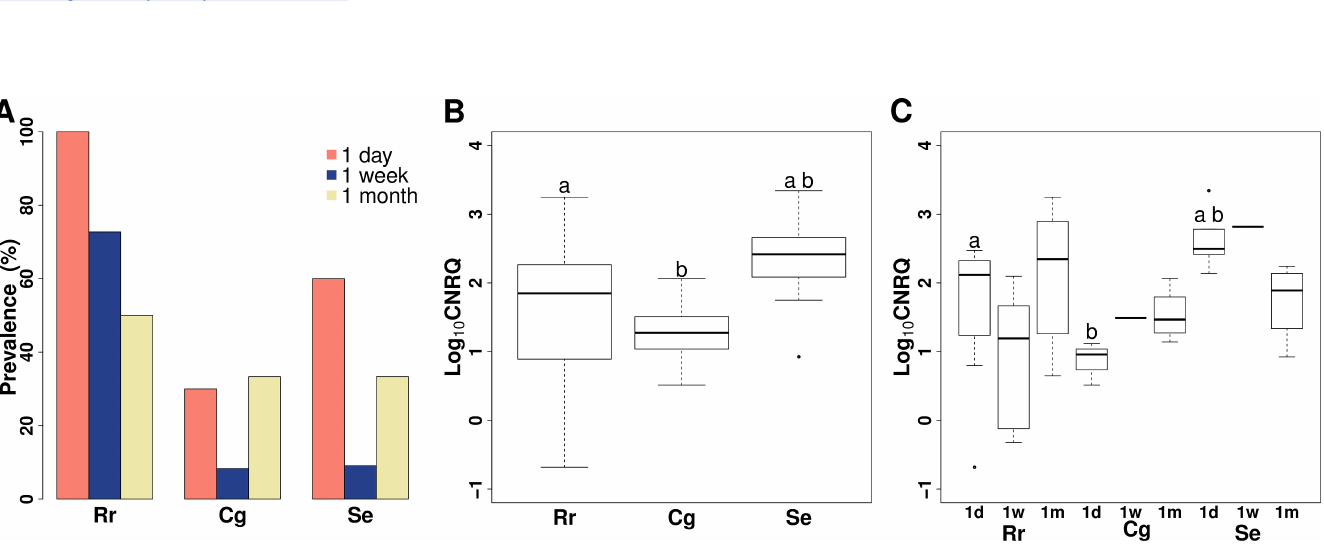
Fig 2. Prevalence and intensity of Myxoboluspseudodispar in host blood in exposure trial #1. (A) Prevalence of the parasite in host species in the relation of sampling time. (B) Boxplot of infection intensity in examined fish species. Significant differences: a: p = 0.043, b: p = 0.041. (C) Boxplot of infection intensity by fish species and at different sampling time. Significant or borderline differences: a: p = 0.087, b: p = 0.016. Rr: common roach Rutilus rutilus ; Cg: gibel carp Carassius gibelio ; Se: rudd Scardinius erythrophthalmus ; Log 10 CNRQ: log10 transformed, calibrated normalized relative quantities of parasite DNA based on qPCR measurements.